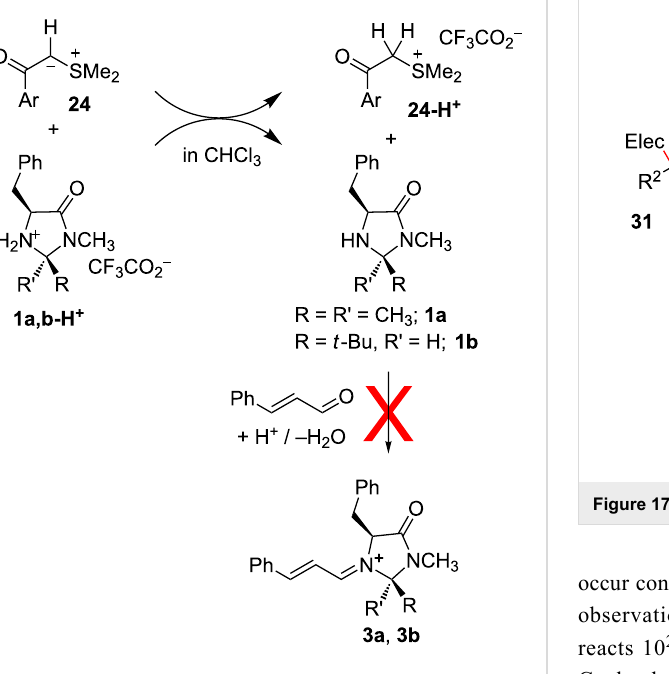
Figure 16: Sulfur ylides inhibit the formation of iminium ions.